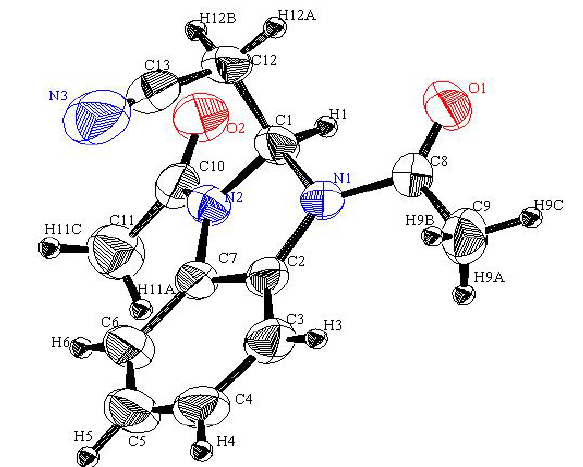
Figure 2. An ORTEP plot of the X-ray crystal structure of 5 .